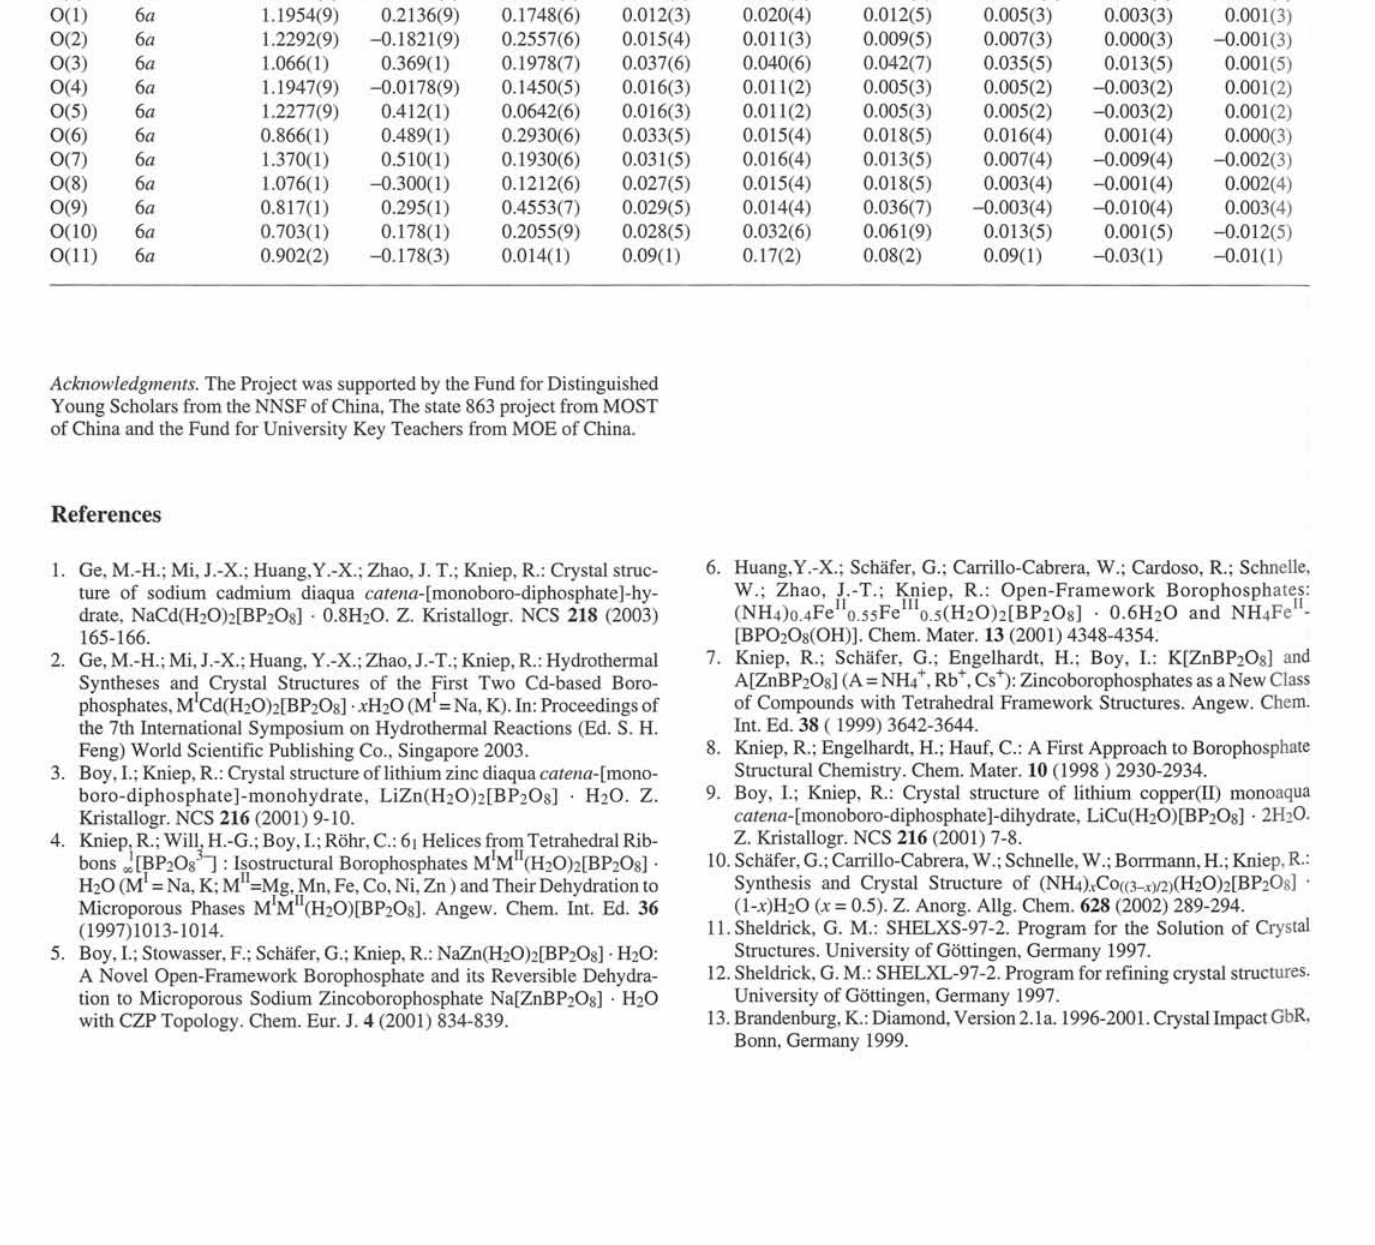
» Ί Table 3. Atomic coordinates and displacement parameters (in